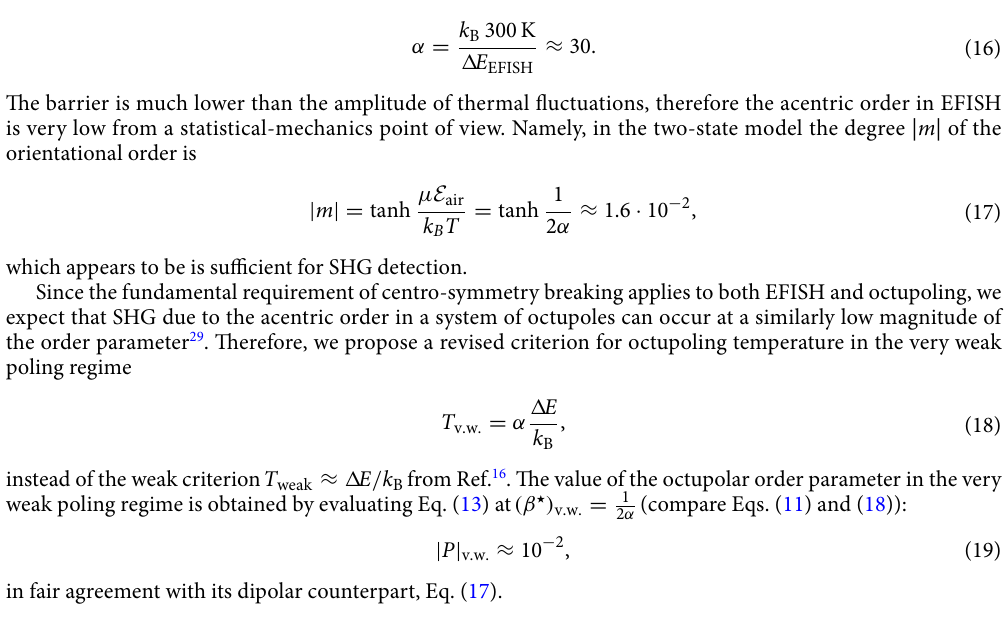
P for the very weak regime is represented by the horizontal | | v.w.